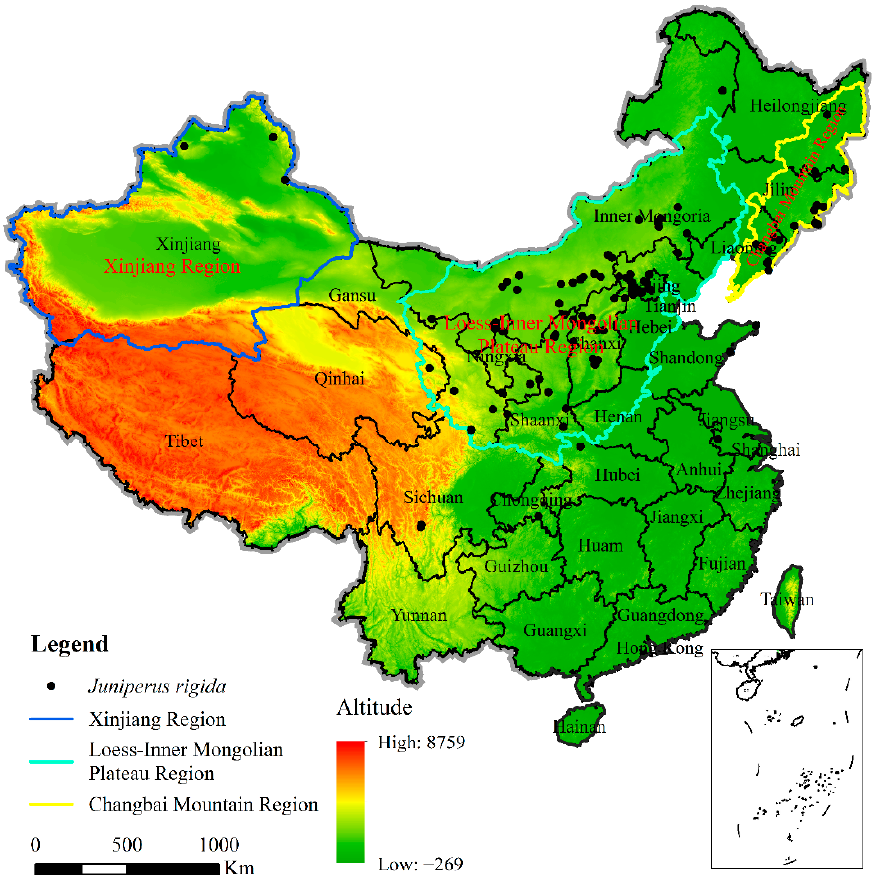
Figure 1. Distribution records of J. rigida in China.